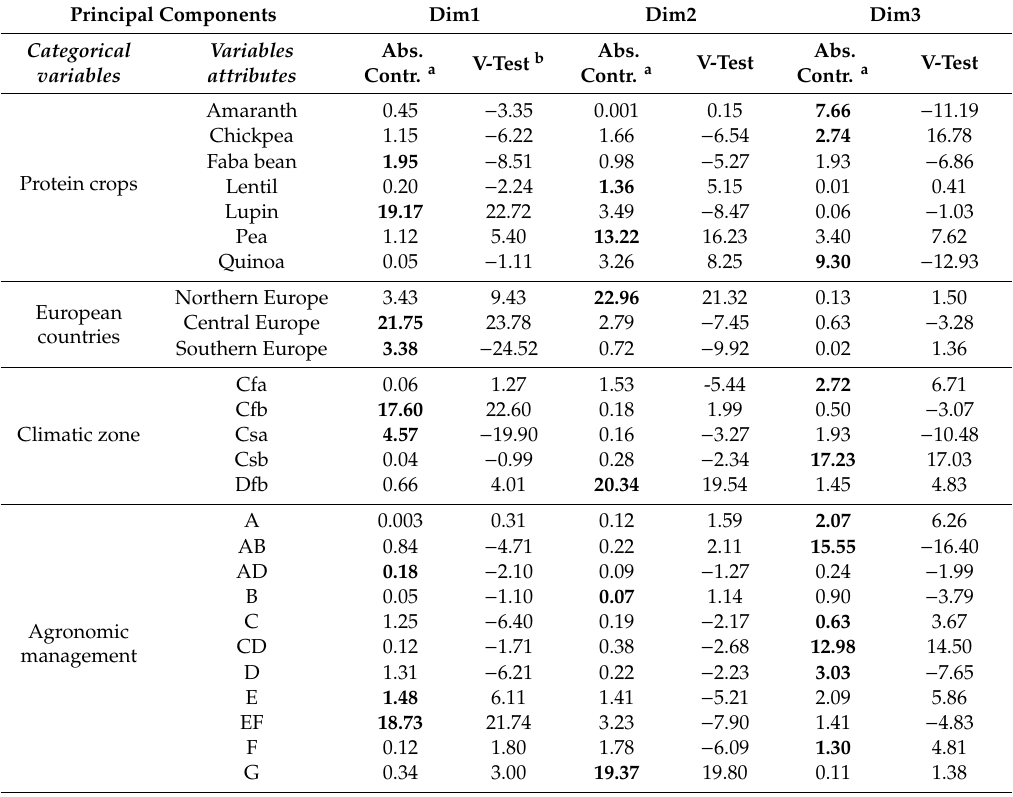
Table 5. Contribution and value test of di ff erent sub categorical variables for systematic review meta-database with respect to the three-dimension components (Dim1 and Dim2 and